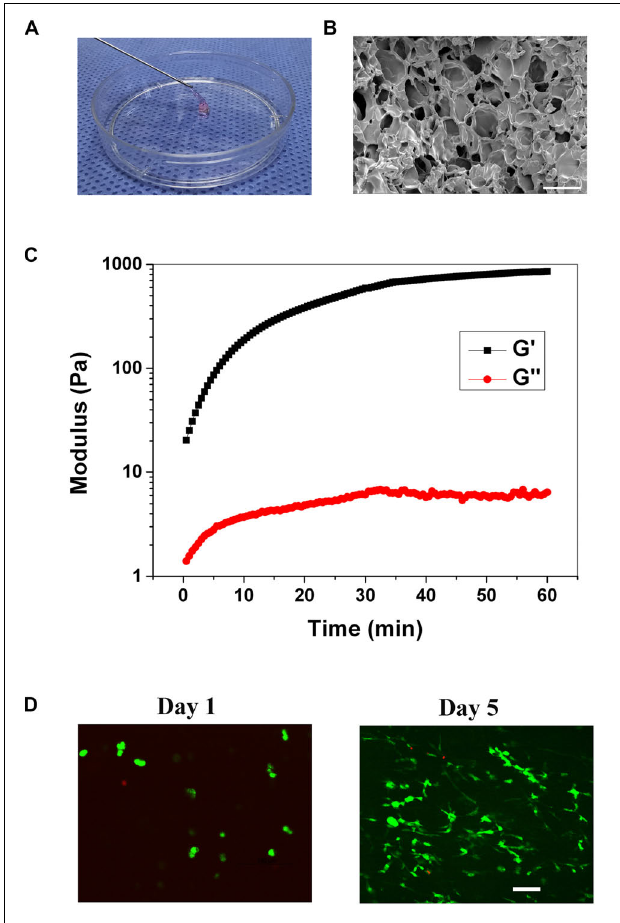
FIGURE 2 | (A) Injection operation of the gelation hydrogel (staining with phenol red). (B) SEM image of the hydrogel, scale bar = 100 µ m. (C) The rheological curve of the hydrogel. (D) Live/dead staining of the cells within the hydrogel on day 1, and 5, scale bar = 100 µ